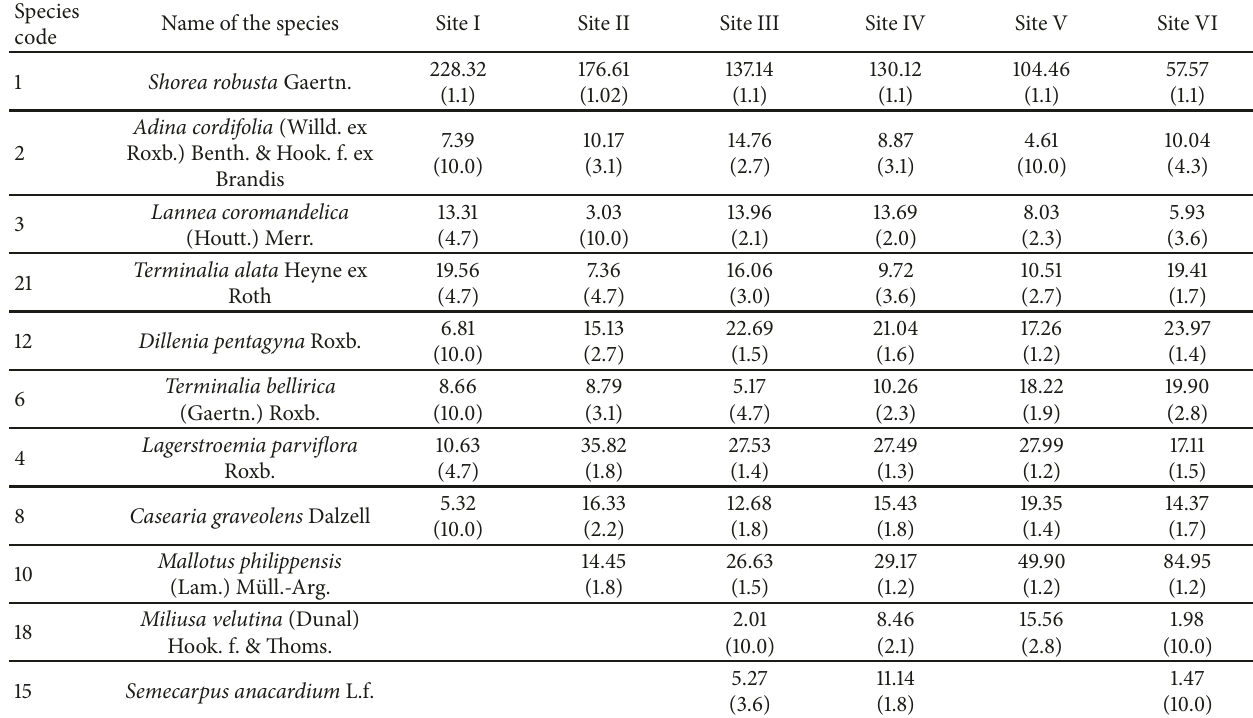
Table 13: IVI of predominant species and Morisita Index of Dispersion in Radha Krishna BZCF.